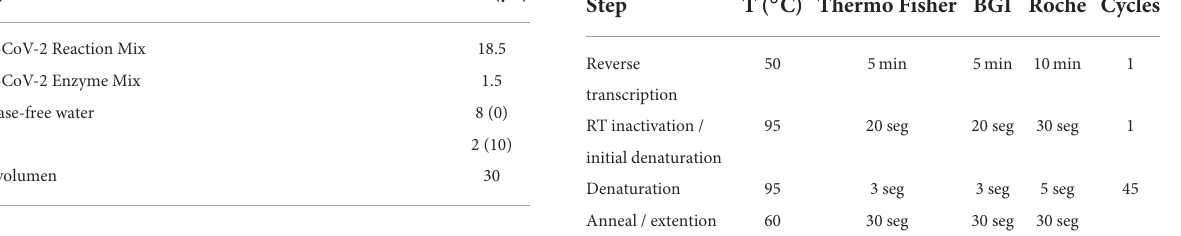
TABLE 4 RT-qPCR thermal